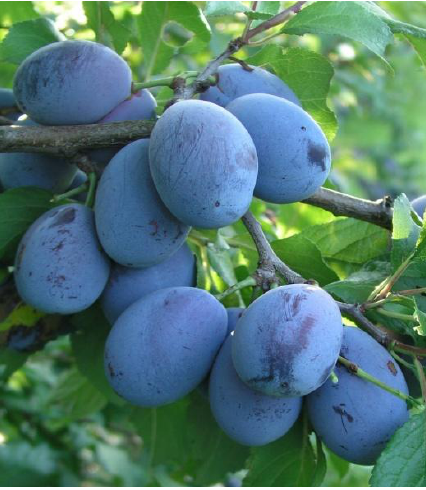
Figure 1. On front page: Fruiting branch of cv. Besztercei szilva Figure 2. On back cover: Cross-section of sprinkled slender (Photo: D. Surányi) xylem on cv. Besztercei szilva (Photo: H.